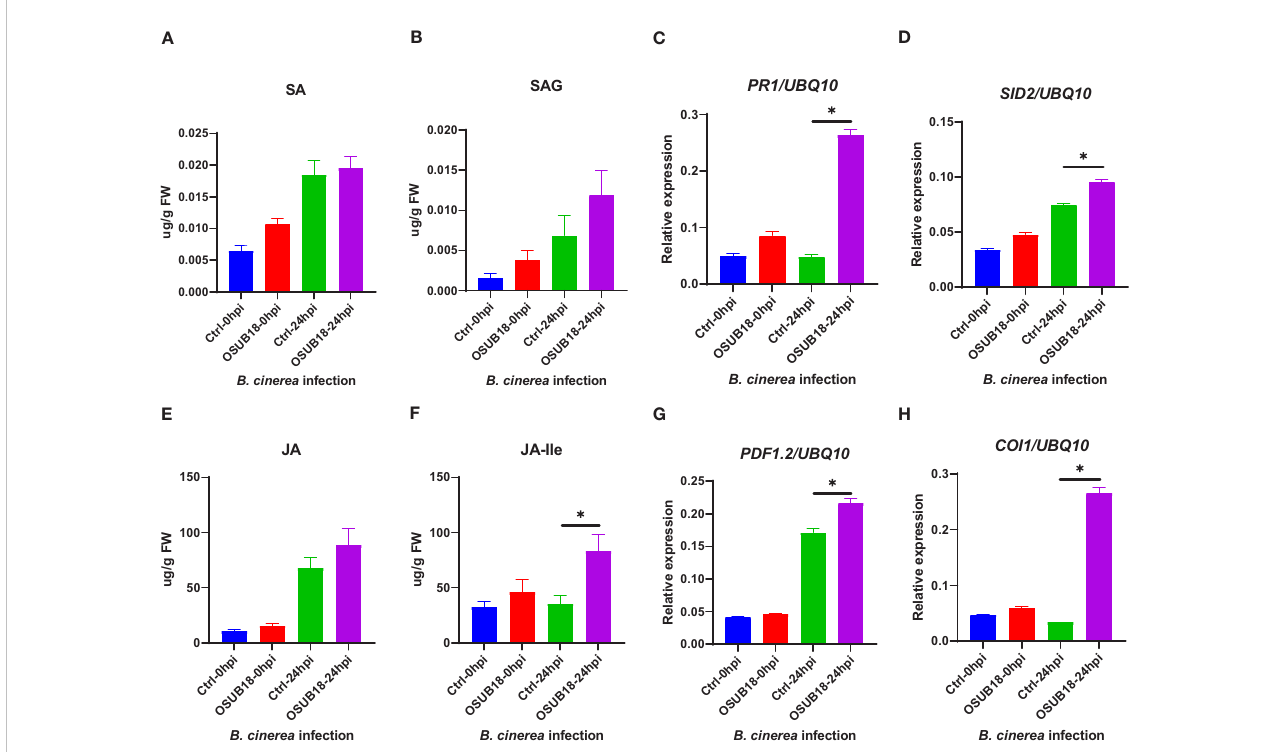
FIGURE 9 OSUB18 root drench treatment increased the JA and JA-related gene expression levels in A thaliana after the fungal pathogen B cinerea infection. (A) Free SA level. (B) Conjugated SA (SAG) level. (C) Relative gene expression of PR1 . (D) Relative gene expression of SID2 . (E) Free JA level. (F) Conjugated JA level. (G) Relative gene expression of PDF1.2 . (H) Relative gene expression of COI1 . Water or OSUB18-drenched plants were infected with B cinerea by spore inoculation. 0 or 24 hours later, the injected leaves were collected for phytohormone quanti fi cation and qRT-PCR assay. The UBQ10 gene was used as an internal reference in the qRT-PCR assay. Data present mean ± SE of three biological replicates. Data with * indicate a p- value < 0.05 on Student ’ s